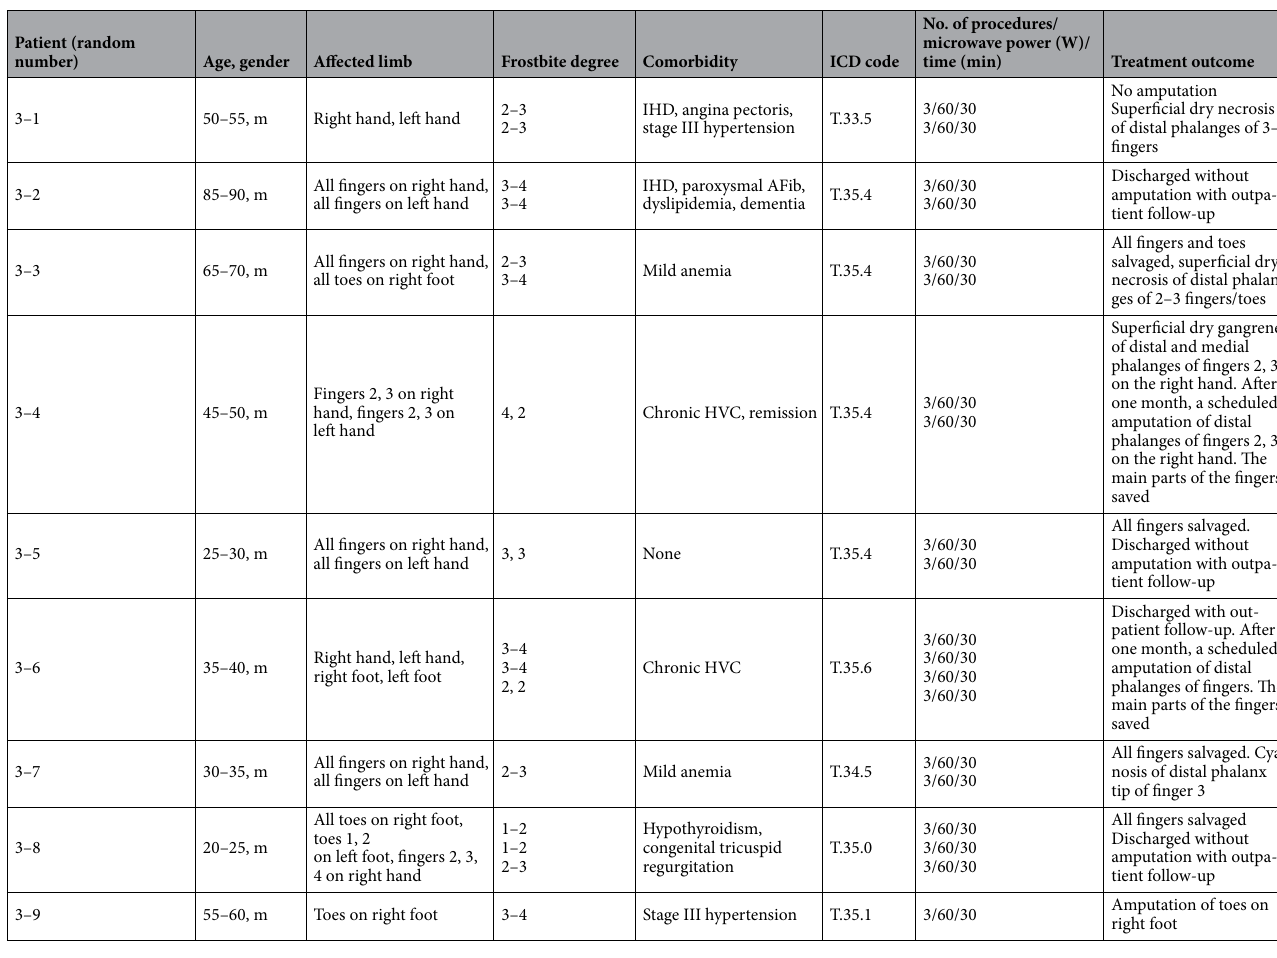
Table 2. Outcomes of frostbite treatment with microwave rewarming in MH No.